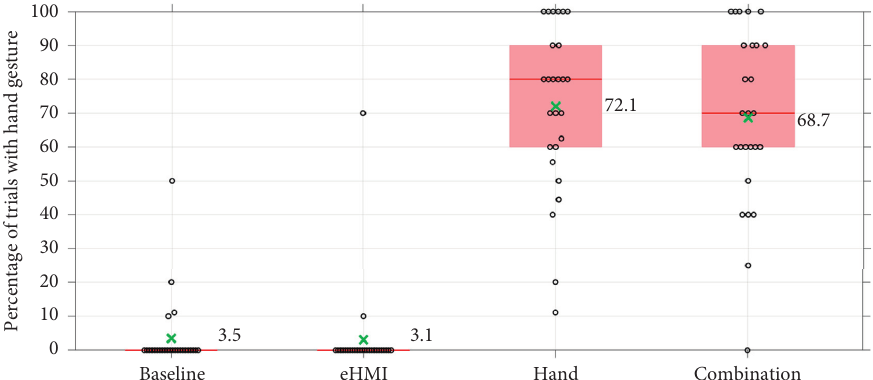
Figure 3: Boxplot depicting the percentage of trials with gesture usage per condition. Each marker represents a participant. The box runs from the 25th to the 75th percentile. The horizontal red line represents the median. The green “ x” and reported number next to it correspond to the mean of